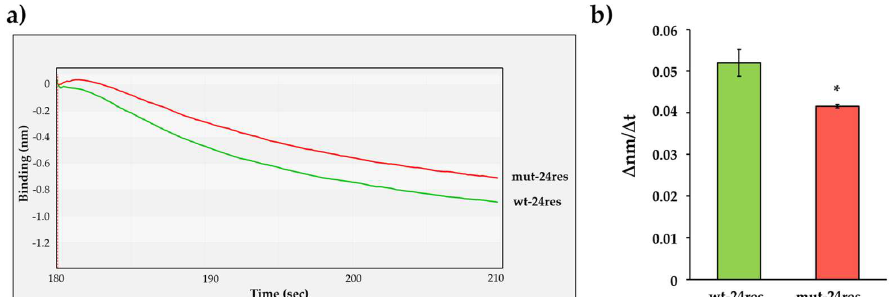
Figure 7. Examination of the substrate groove of HIV-1 PR. ( a ) A representative sensogram of the enzyme reactions performed with wt-24res and mut-24res substrates. ( b ) Comparison of obtained ∆ nm/ ∆ t values. The initial ∆ nm/ ∆ t values were determined based on the slopes (2–10 s after initiation of the reaction). *: p = 0.0463. Error bars represent SD (n = 2). Representative signal curves are shown for all steps of the assay in Figure S3c.